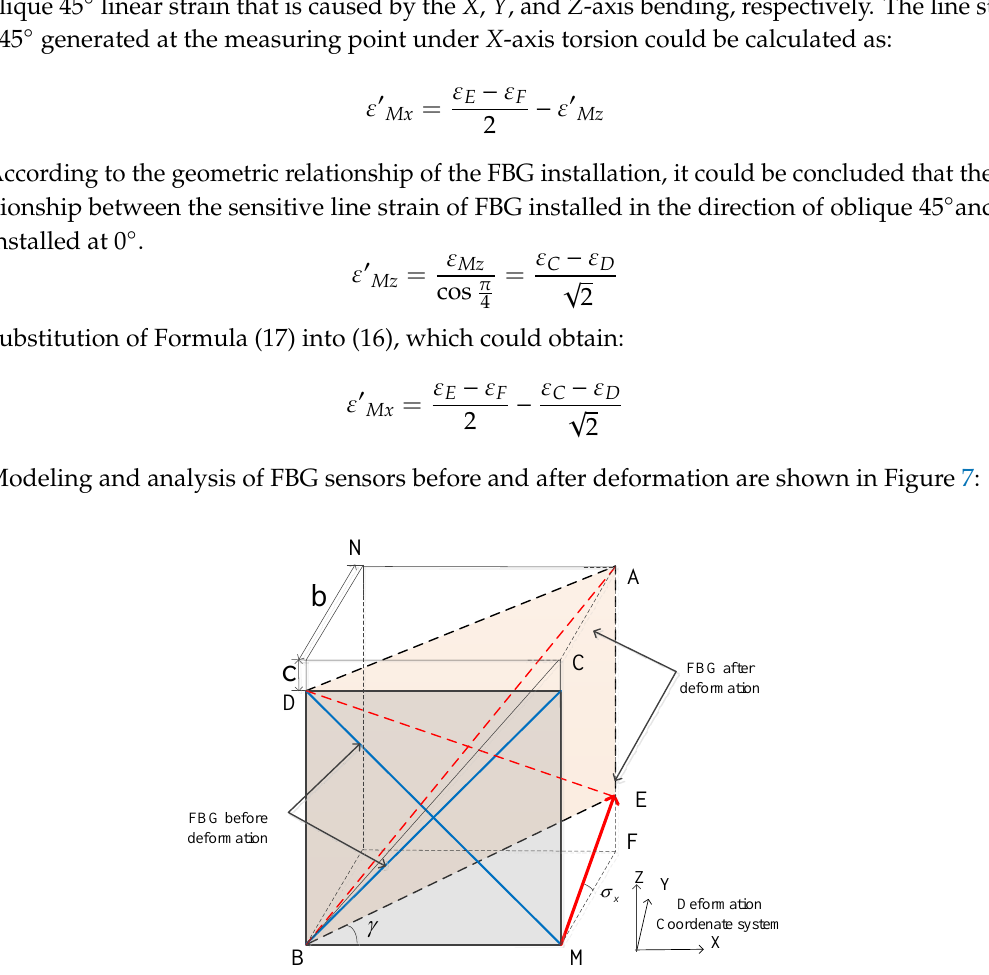
Figure 7. Schematic diagram of fiber grating deformation.